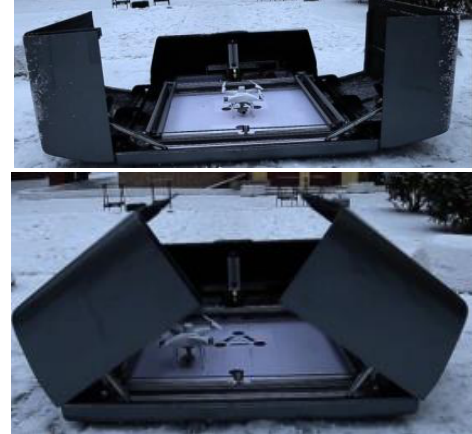
Figure 6. Skysence USA Charging Station